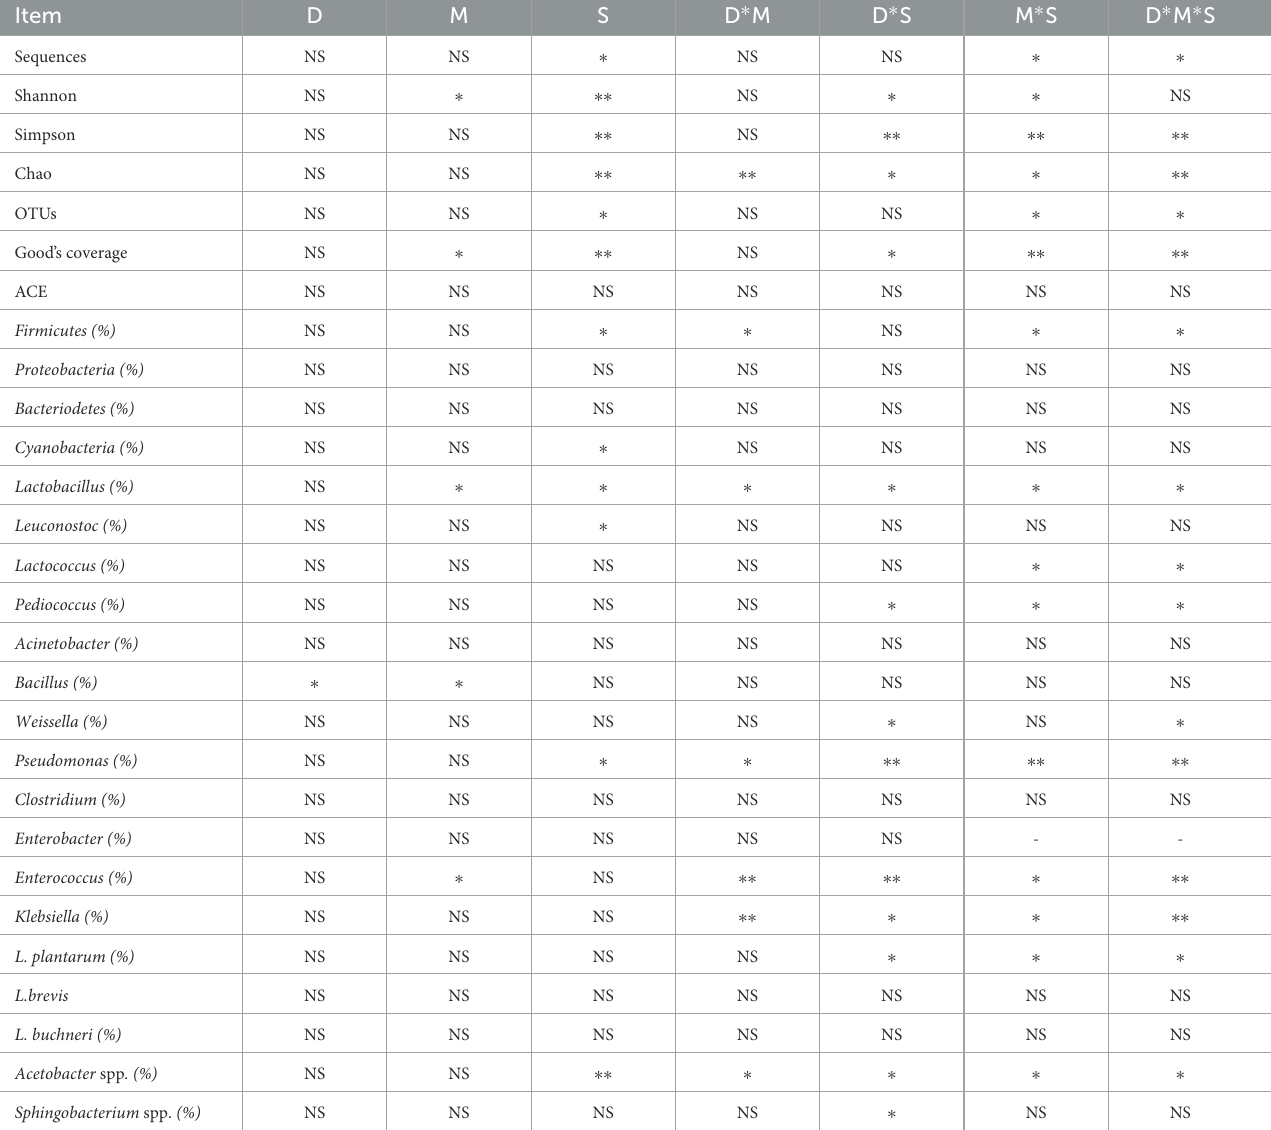
TABLE 3 Interaction effects of the lactic acid dose, microbe type, and substrate on the bacterial diversity of the silage.